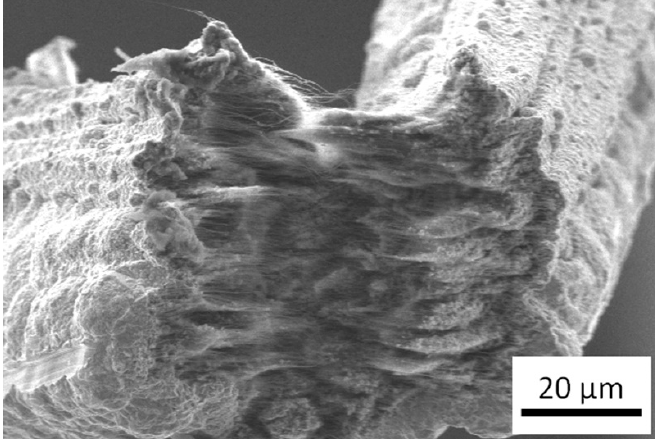
Figure 7. Fractured surface of CNT-Cu composite material synthesized by low current electrodeposition.